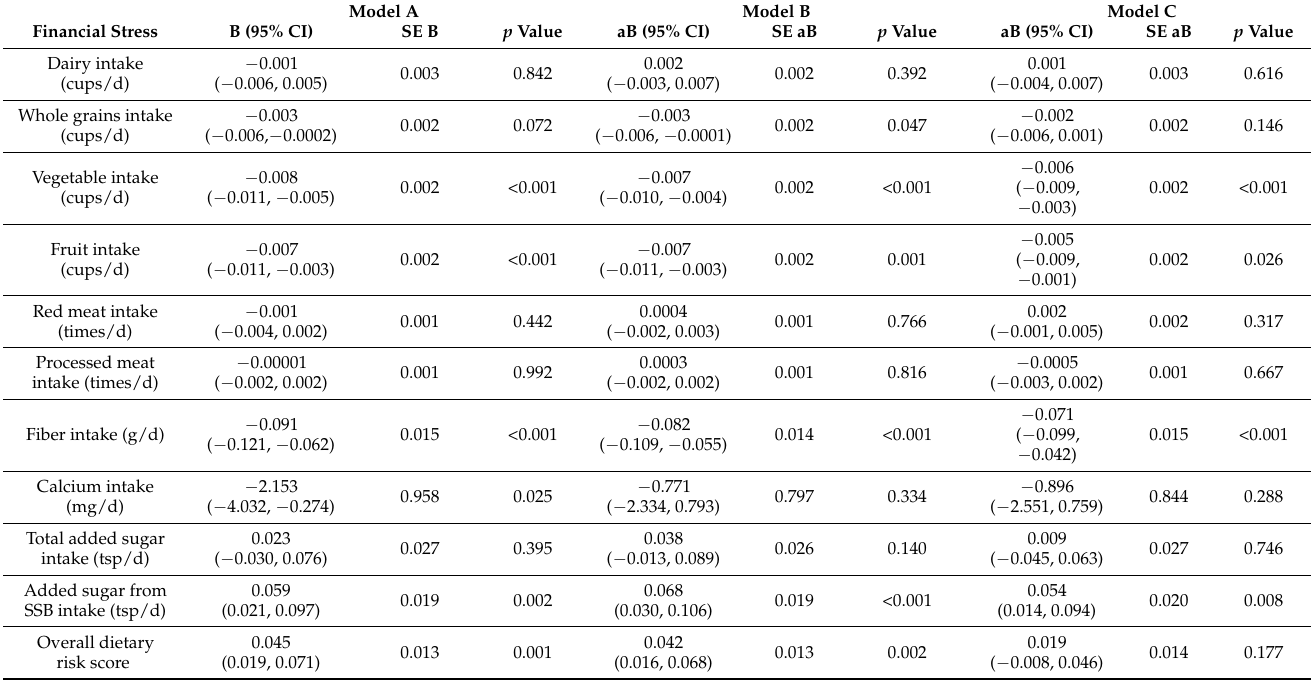
Table 5. Financial stress and its association with dietary intake and dietary risk score. Model A Model